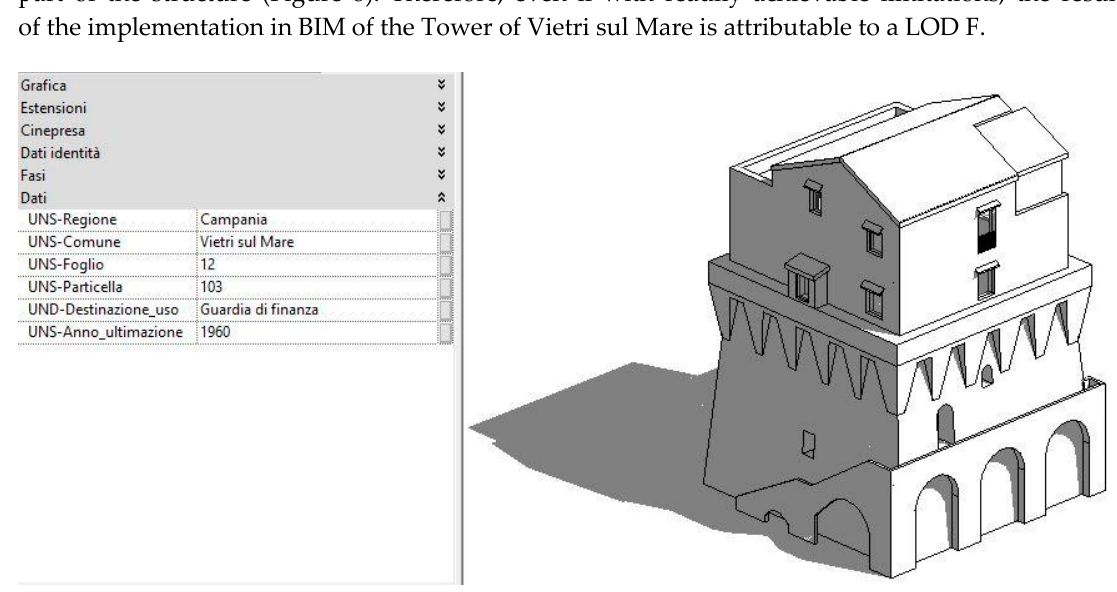
Figure 7. BIM Model of the Tower representing its present state.